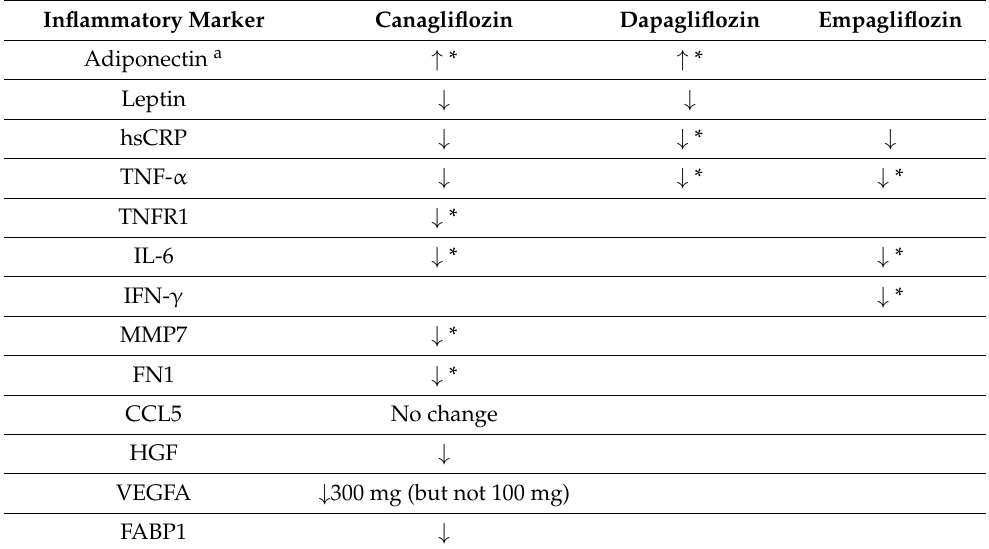
Table 2. Changes in inflammation and fibrosis markers in patients with T2D treated with SGLT2is [145,146]. Increase in level is marked as “ ↑ ”, decrease as “ ↓ ”, and significant changes ( p < 0.05) as